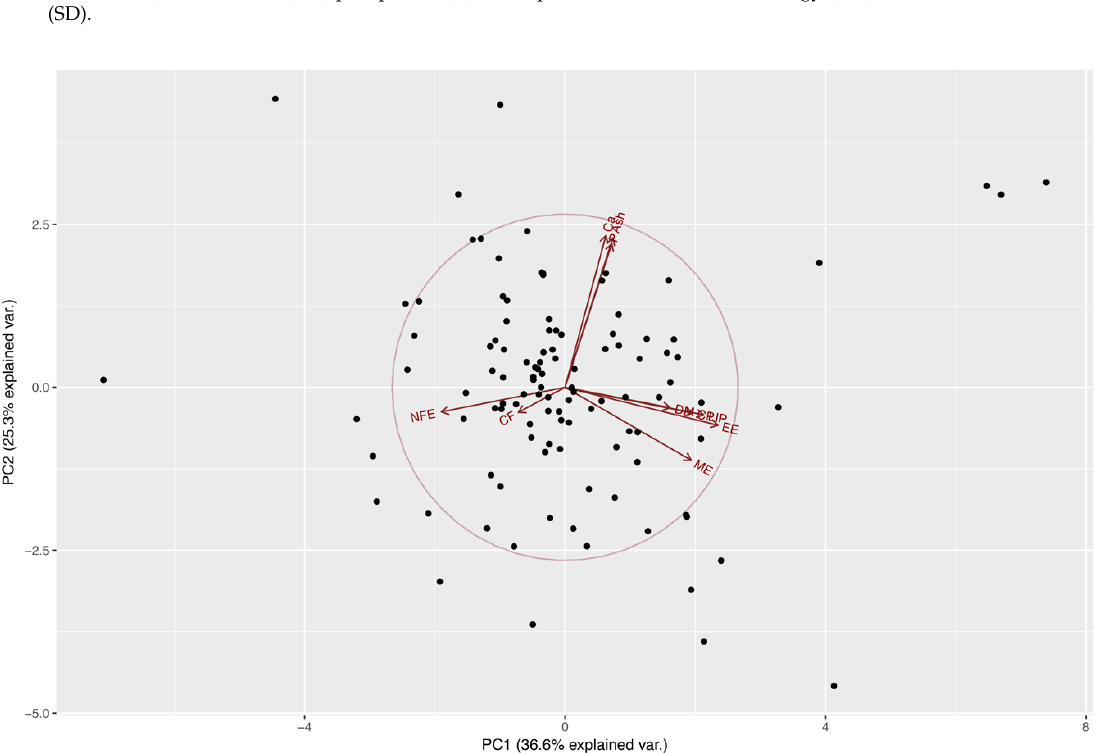
Figure 1. Distribution of food preference of kennel dogs, on the first two principal components extracted from estimate contents of dry matter (DM), crude protein (CP), crude fiber (CF), ether extract (EE), nitrogen-free extract (NFE), ash, calcium (Ca), phosphorus (P), total lipids (LIP), and metabolizable energy (ME) by proximal chemical analysis, acid hydrolysis, and calorimetric pump food decomposition.